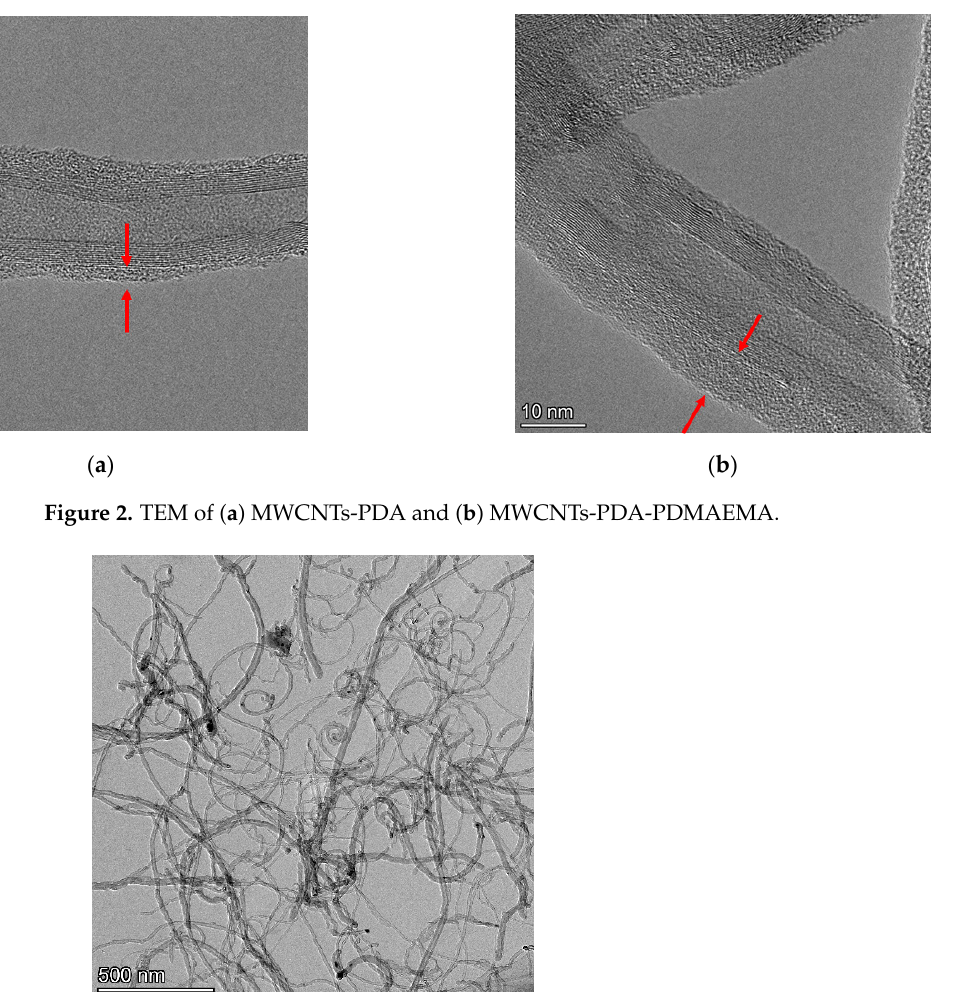
( b ) Figure 5. ( a ) UV-Vis transmittance of composite and water mixture at 610 nm with 6 CO 2 /N 2 purge cycles; ( b ) UV-Vis transmittance of composite and water mixture at 610 nm against time.